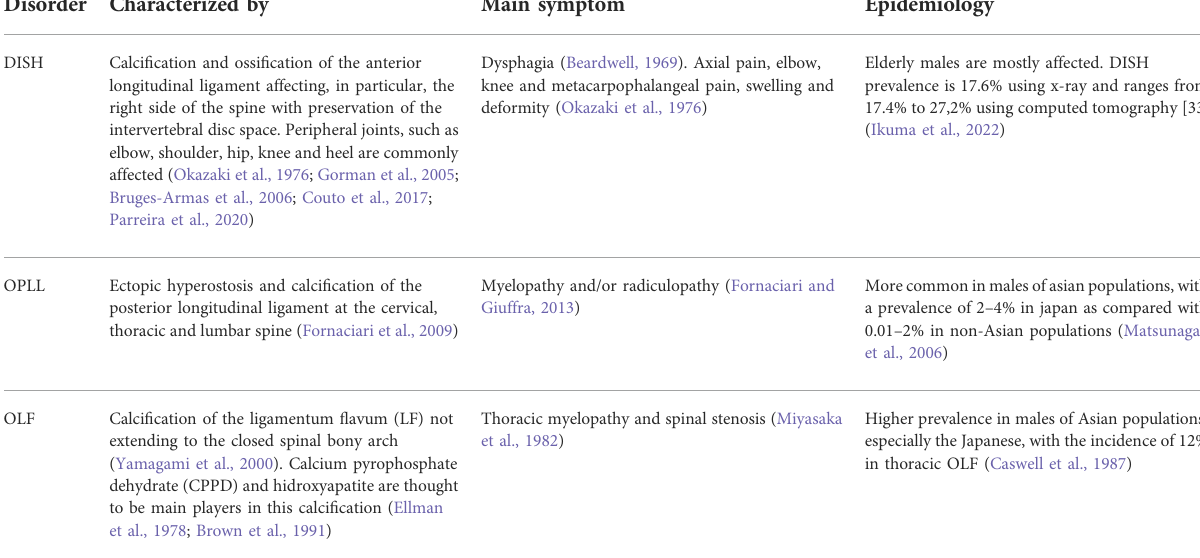
TABLE 1 Brief characterization, main symptoms and epidemiology of DISH, OPLL and